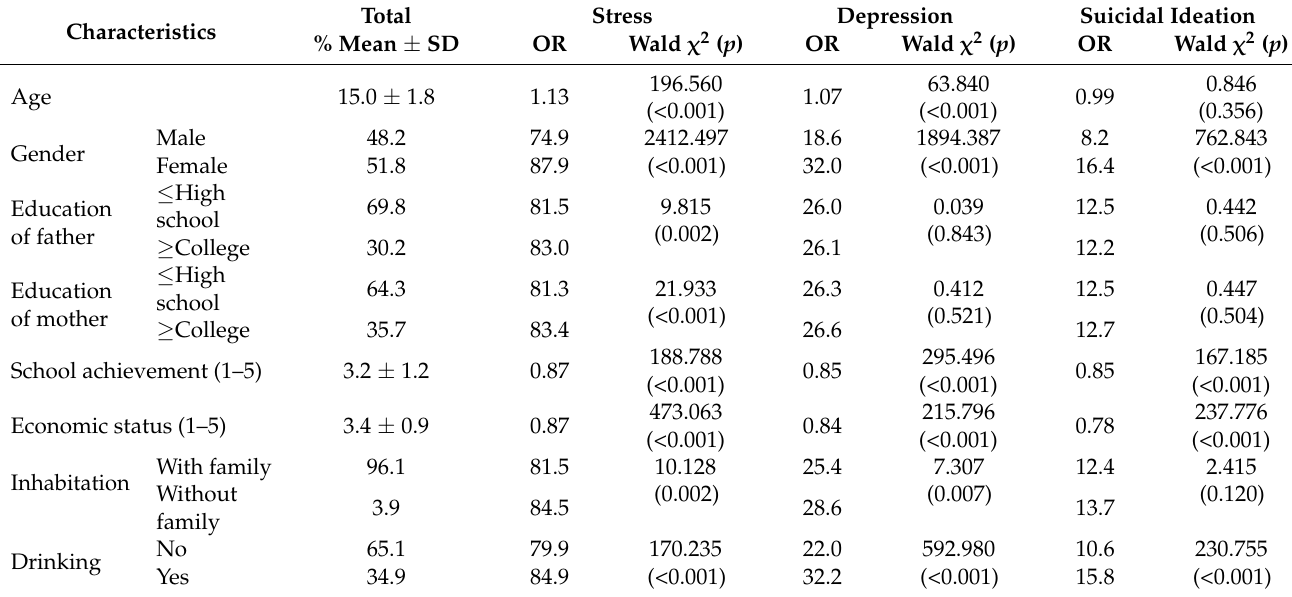
Table 1. General characteristics and single effects on stress, depression, or suicidal ideation.